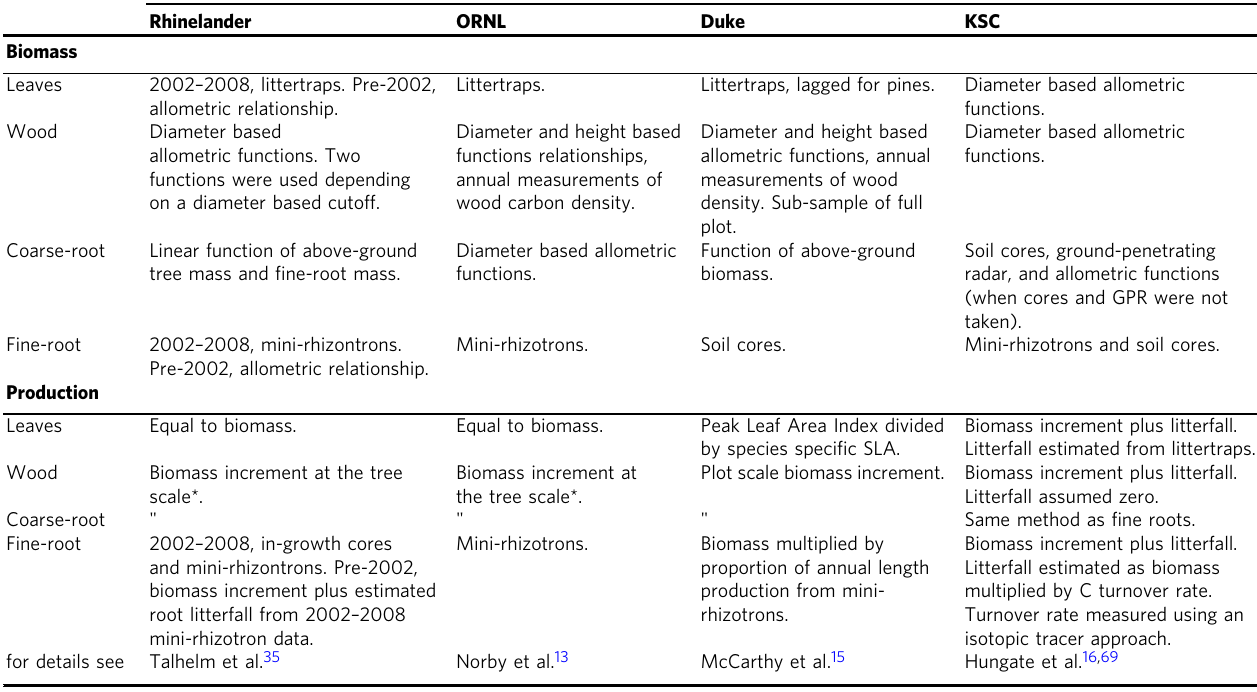
Table 4 Comparison of various methods used to calculate biomass and NPP at the four